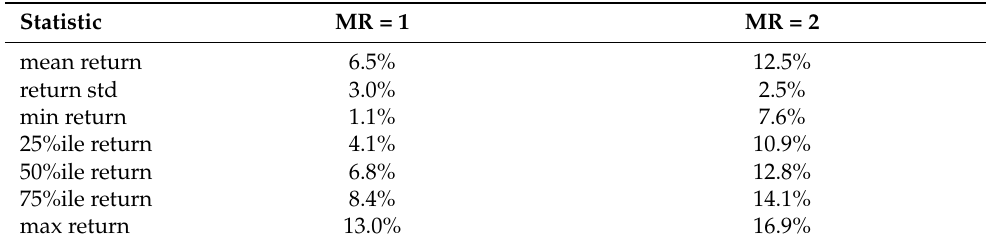
Table 1. Return statistics of the reversals strategy after 10 years for 20 industry simulations. We run the simulations for mean reversions of 1.0 and 2.0.